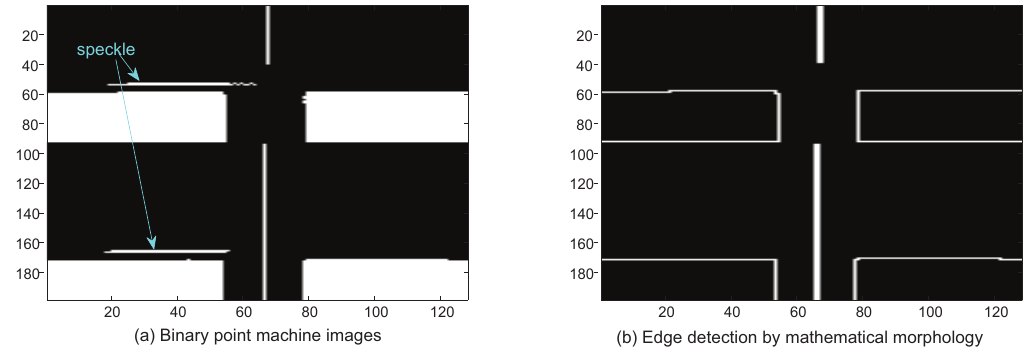
Figure 8. Mathematical morphology-based edge